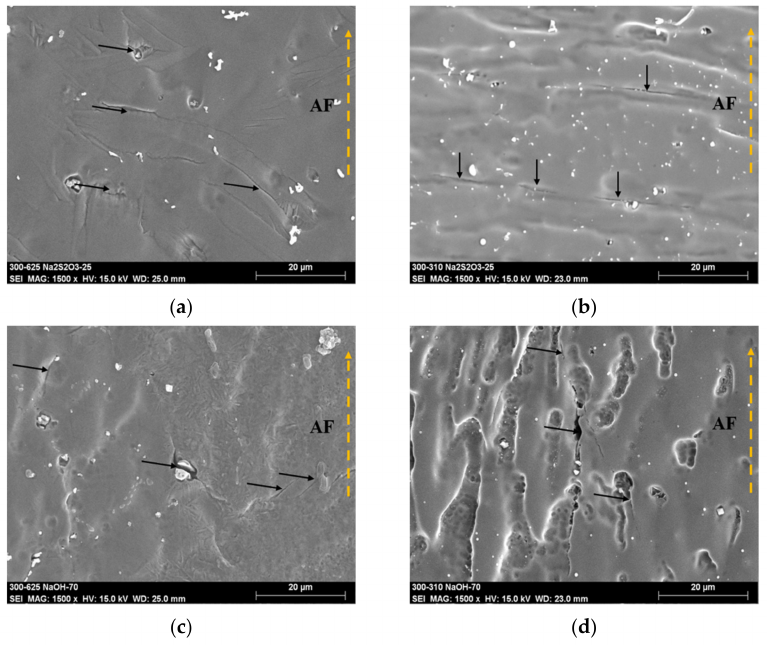
Figure 10. The secondary cracking of IN600 welds after SSRTs in ( a , b ) Na 2 S 2 O 3 at RT and ( c , d ) NaOH at 80 ◦ C. AF = applied force direction, ( a , c ) corresponds to the ERNiCrMo-3 weld and ( b , d ) to the ER310 weld. Black arrows point to the secondary cracks.